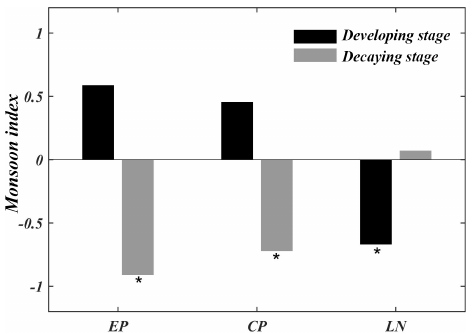
Figure 7. The western North Pacific and eastern Asian (WNP-EA) summer monsoon index during different ENSO phases (average for 1971–2000 is − 0 . 007). The asterisk indicates 95%